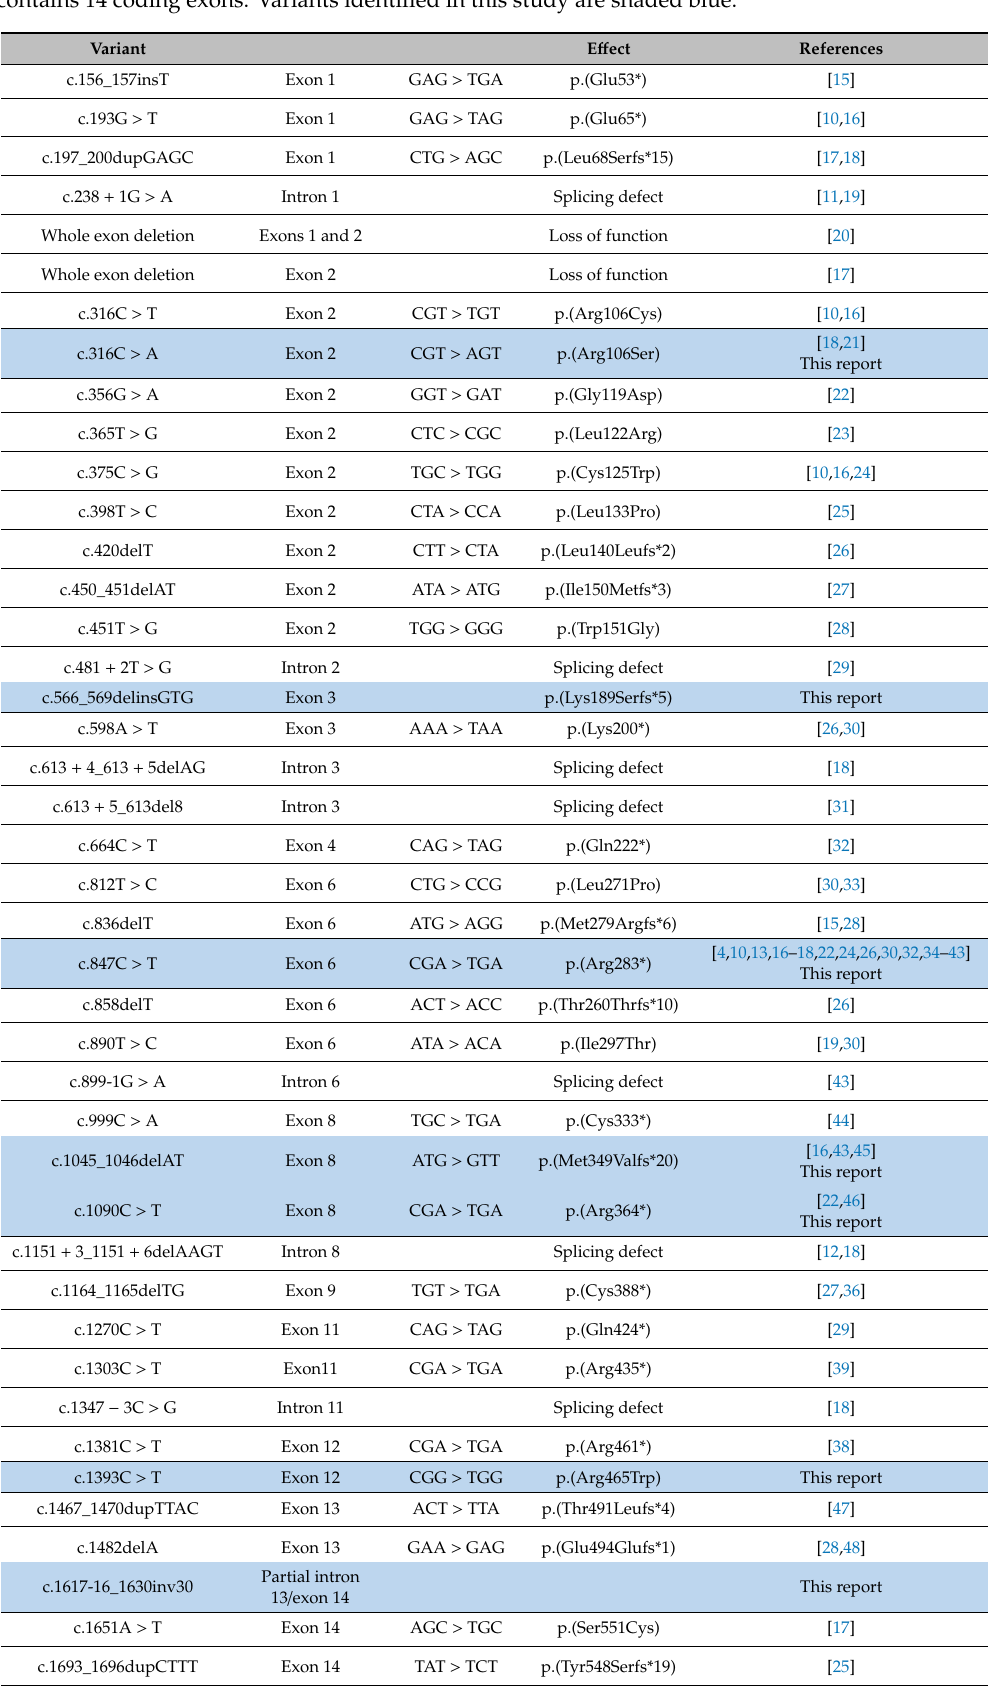
Table 1. Variants identified in CERKL to date. Numbering is based on transcript NM_001030311 which contains 14 coding exons. Variants identified in this study are shaded